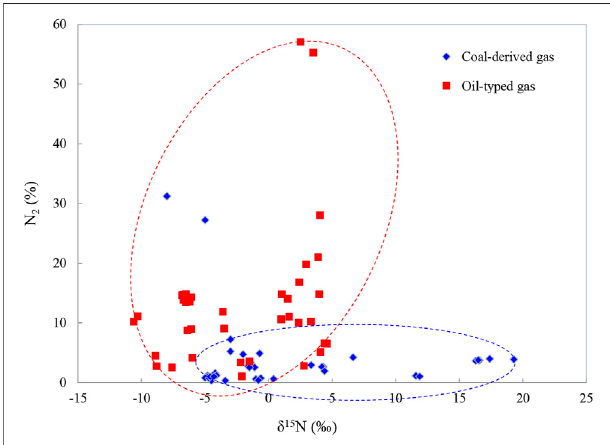
FIGURE 6 | Relationship between nitrogen content and isotope in coal- derived gas and oil-typed gas in China.